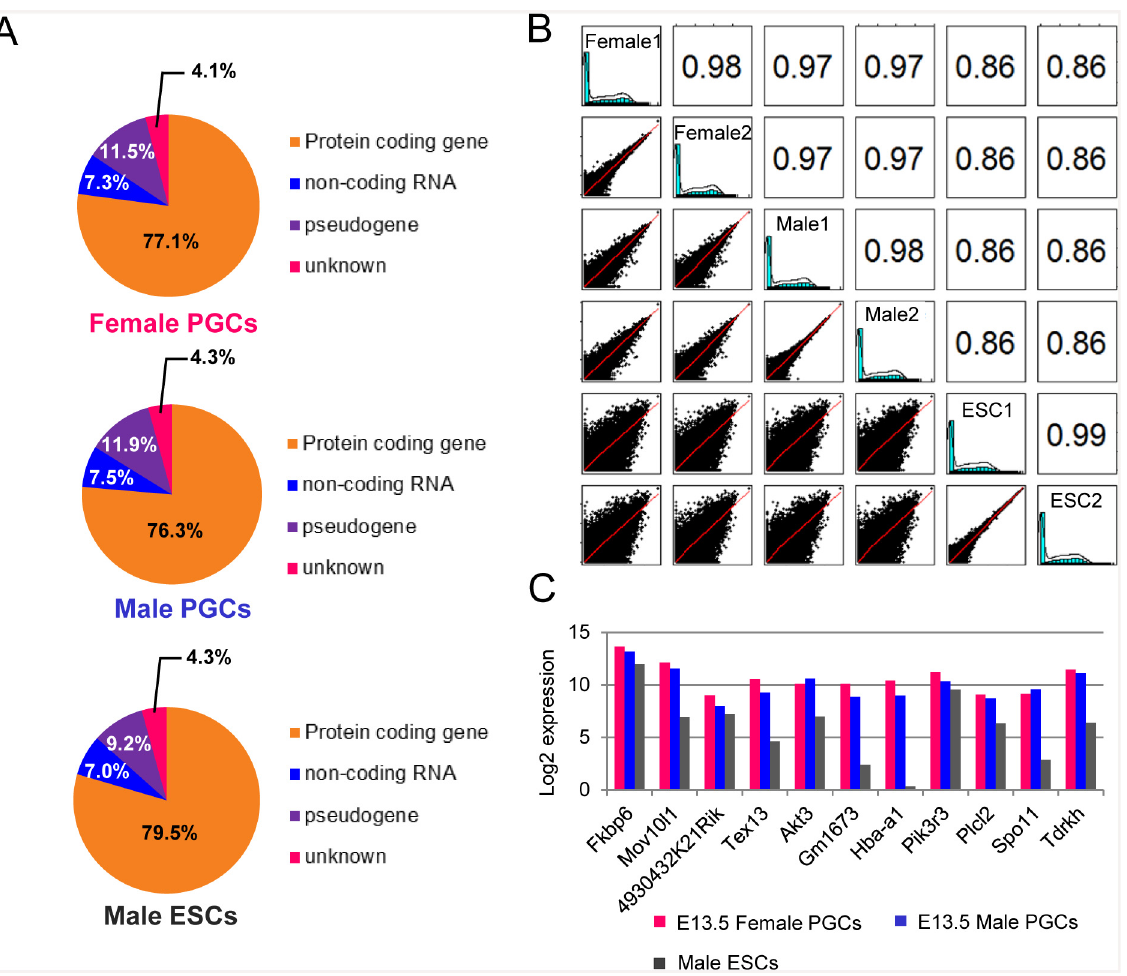
Fig 1. RNA-seq transcriptional profiling of female and male PGCs. (A) Pie charts showing the composition and quantity of each reference gene type in the UCSC Genome Browser for each RNA-seq dataset. (B) Comparative analysis of reference gene expression levels in each RNA-seq dataset. The left side-scatter plots display the relationship between each gene expression pattern. The right side numbers are the Pearson ’ s correlation coefficients. (C) PGC- specific gene expression patterns (11) in each RNA-seq dataset. Expression levels are shown in log2